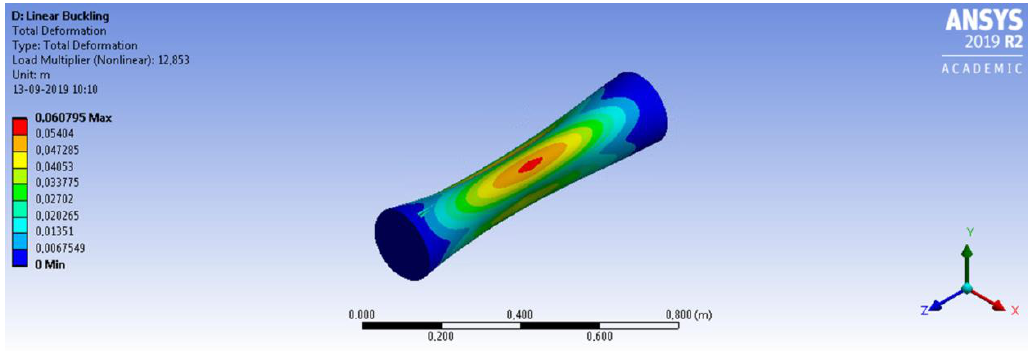
Figure 14. Linear buckling analysis results for the shell with sliding stiffeners.